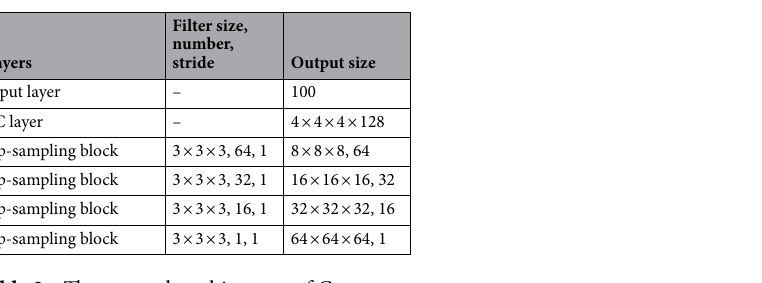
Table 2. The network architecture of